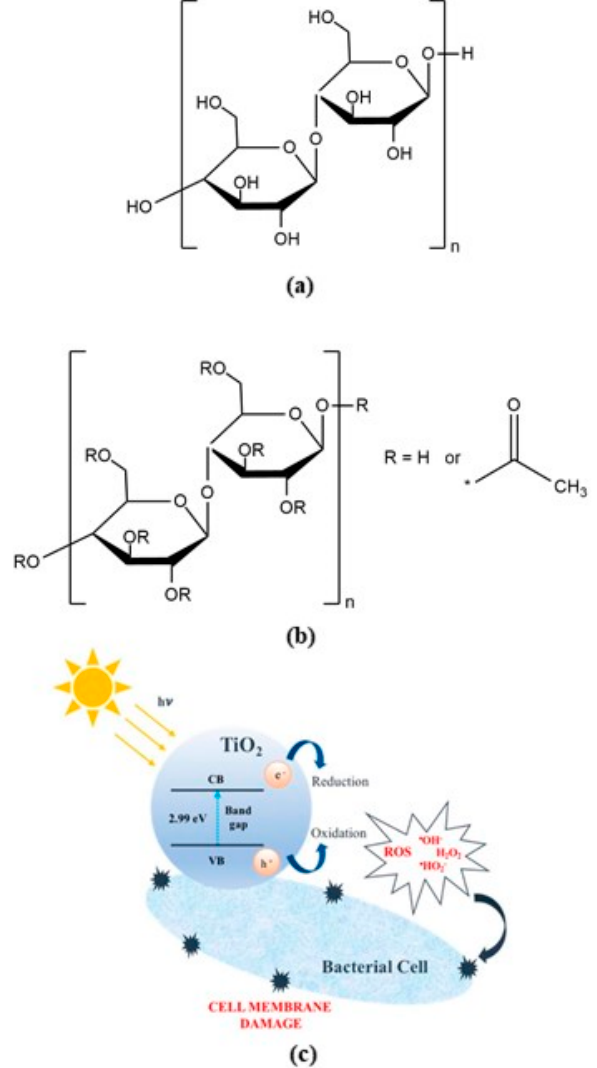
Figure 1. ( a ) Molecular structure of cellulose; ( b ) Molecular structure of cellulose acetate (CA); ( c ) Amorphous titania ROS production Illustration obtained with permission from Matos et. al. [25].